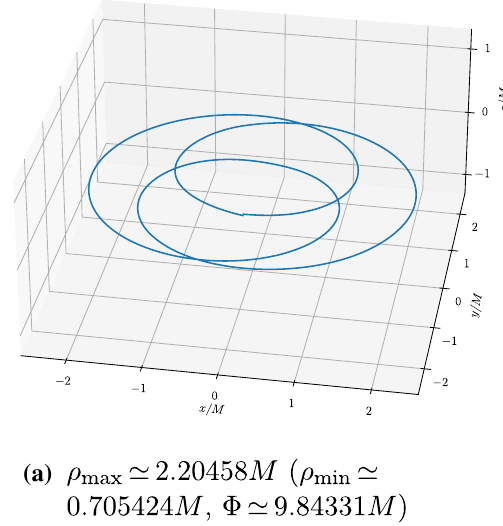
Fig. 2 Examples of non-circular equatorial FPOs for the case L = M / 2, with parameters as indicated. The choice of parameter for a is explained at the end of Sect. 6.2; the parameter for b was chosen to